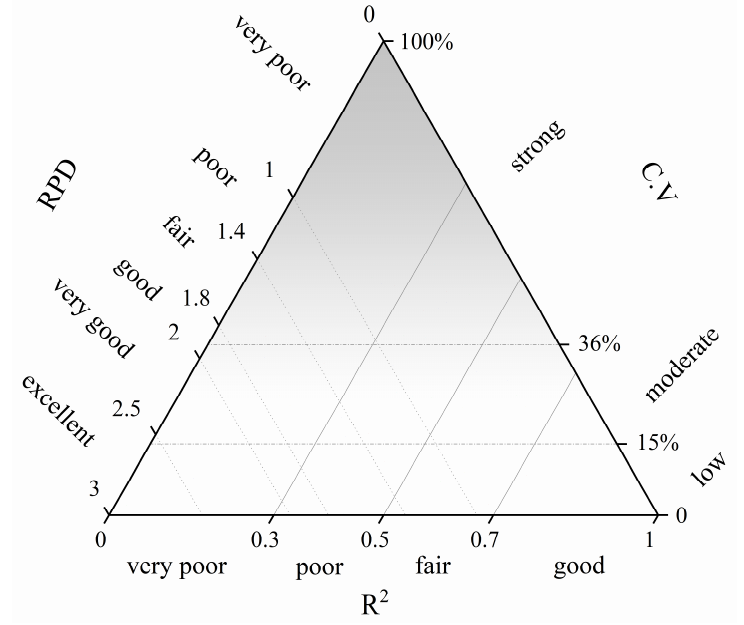
Figure 3. Chart for empirical judgment criteria of evaluation indicator value